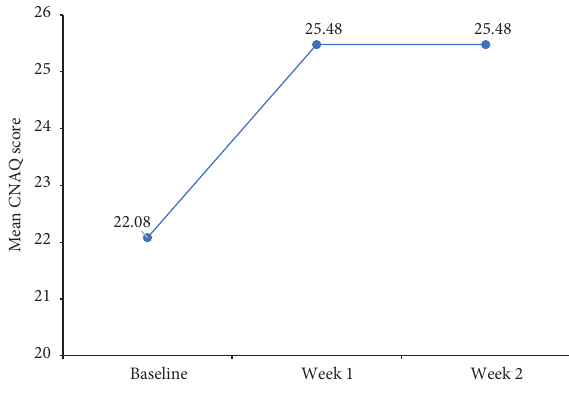
Figure 2: Mean change in CNAQ scores at weeks 1 and 2 from baseline (ITT population) ∗ . ∗ ITT population including all patients who are analyzed in the study. CNAQ, Council on Nutrition Appetite Questionnaire; ITT, intention to treat.